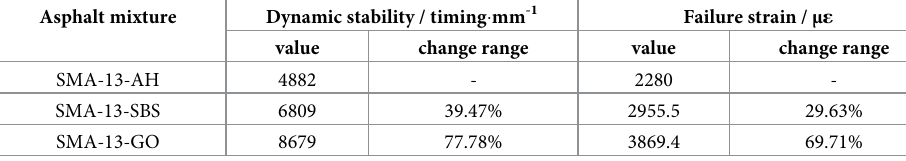
Table 9. High and low temperature performance indices of 3 asphalt